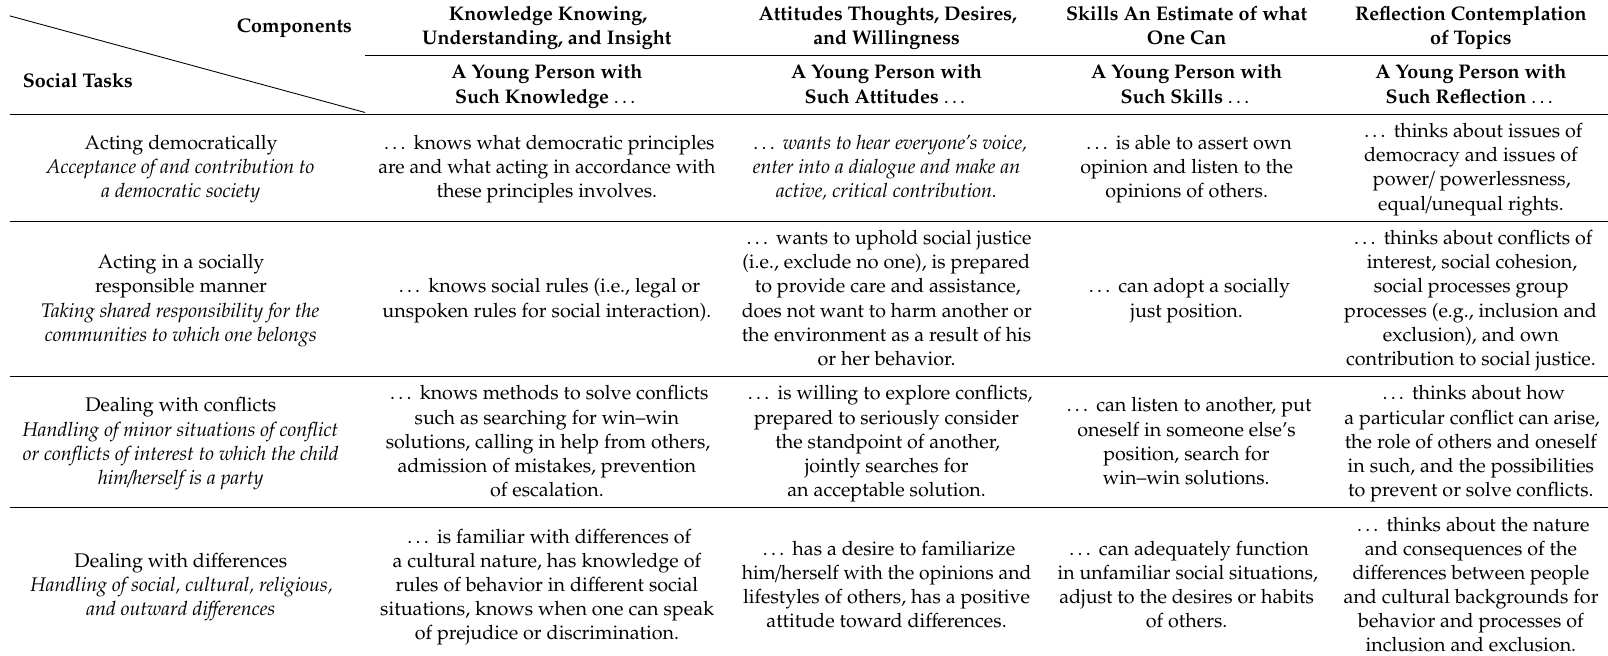
Table A2. Conceptual framework citizenship competences (components and social